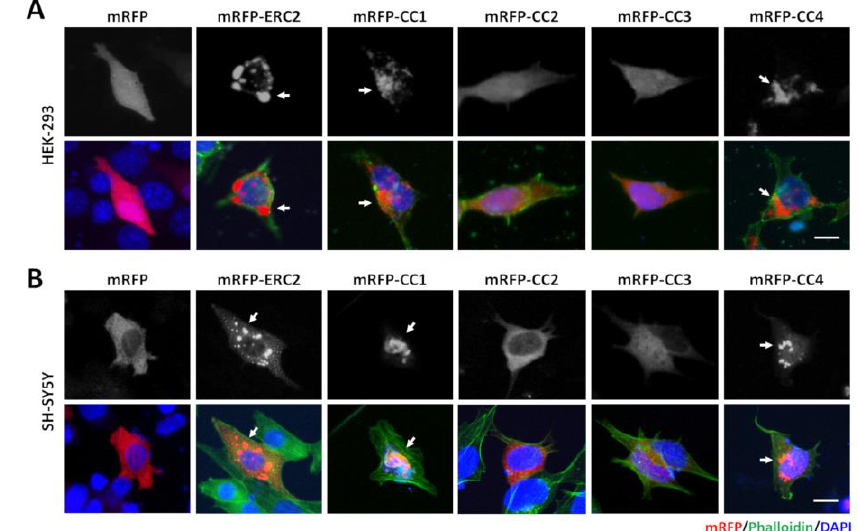
Figure 3. CAST1 / ERC2 forms aggregate when expressed in heterologous cells. Representative images of ( A ) HEK293T and ( B ) SH-SY5Y cells transfected with mRFP, mRFP-CAST1 / ERC2 or mRFP-tagged CC domains plasmids. Forty-eight hours after transfection cells were fixed and observed by fluorescent microscopy. Phalloidin conjugated with Alexa-488 was used to define cell morphology. In both cell types, CAST1 / ERC2 and domains CC1 and CC4 (arrows) formed large aggregates. In contrast, CC2 and CC3 exhibited a di ff use pattern. For HEK293T cells the amounts of mRFP-ERC2, mRFP-CC1 / CC2 and mRFP-CC3 / CC4 plasmids used for transfection of a 24-well plate were 0.5 µ g / well, 0.4 µ g / well and 0.3 µ g / well, respectively. For SH-SY5Y cells the amount of mRFP-ERC2, mRFP-CC1 / CC2 and mRFP-CC3 / CC4 plasmids used for transfection of a 24-well plate was 1.0 µ g / well, 0.8 µ g / well and 0.6 µ g / well, respectively. Scale bars: 5 µ